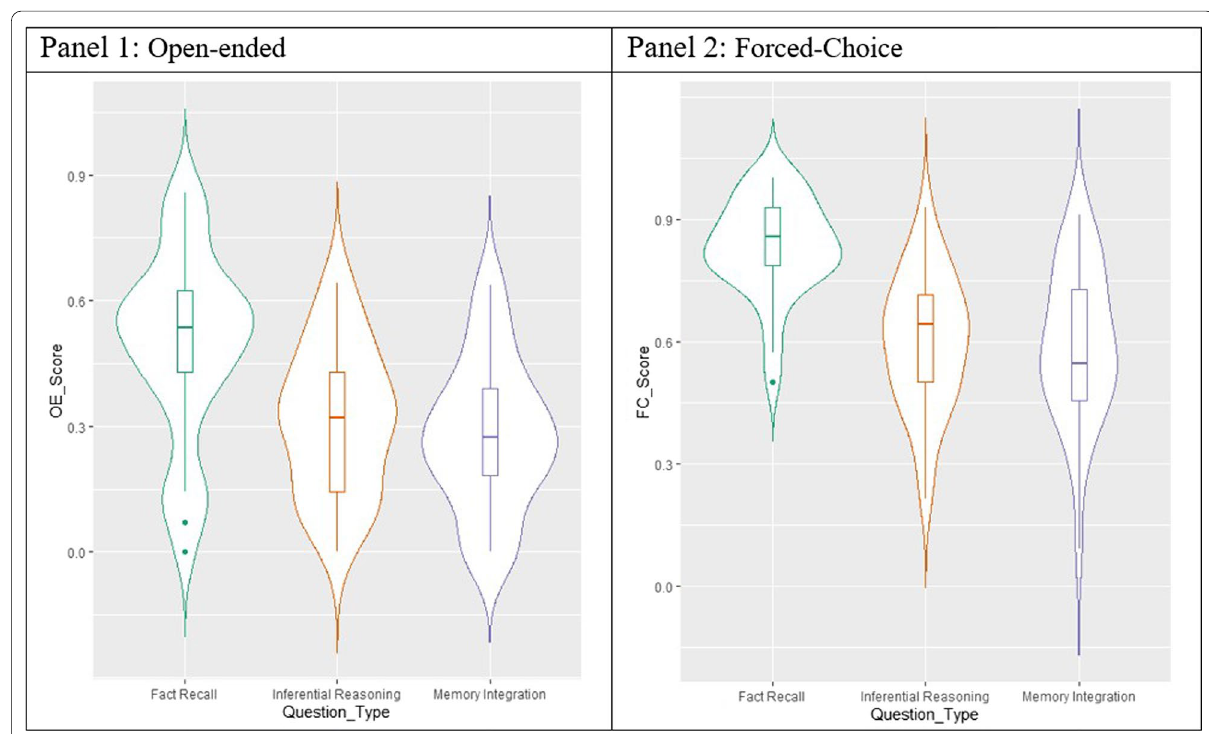
Fig. 3 Open-ended (OE_Score) and forced-choice (FC_Scores) across three question types in Experiment 1 . Note Violin plots depict variability and proportion correct for open‑ended (OE_Score) and forced‑choice (FC_Score) within three question types (fact recall, inferential reasoning, and memory